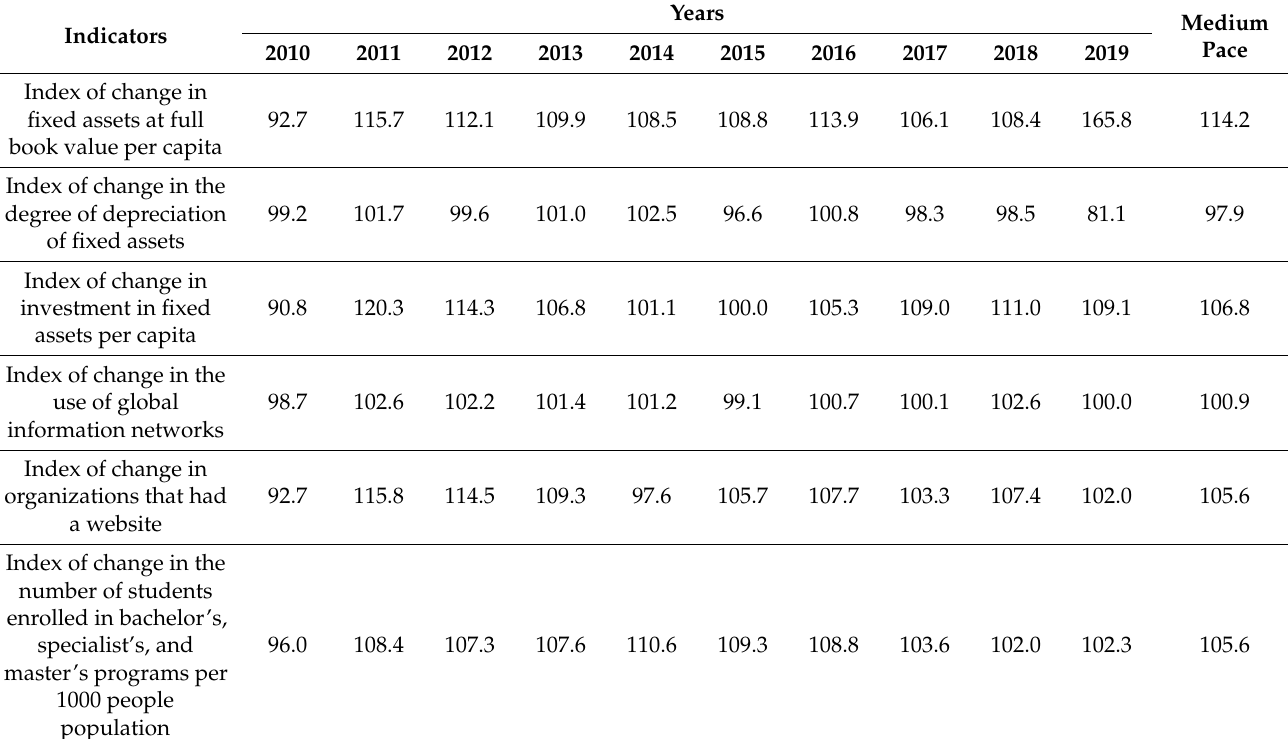
Table 12. Dynamics of changes in indicators characterizing the macro-regional block “Prospects” in the Russian Federation in 2010–2019, in % of the previous